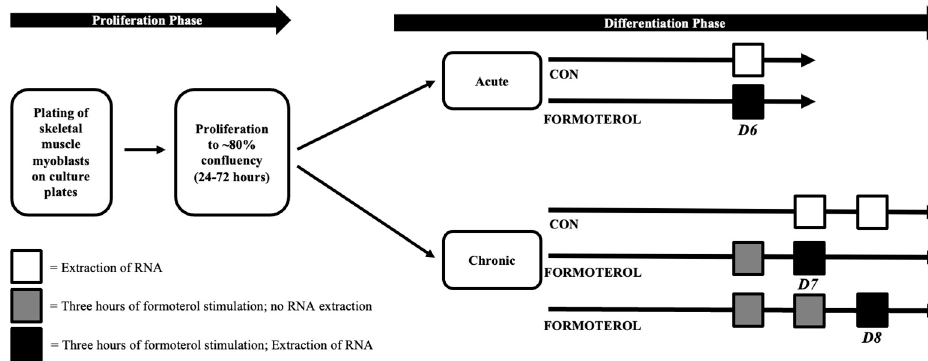
Figure 6. Overview of study timeline and methodology.